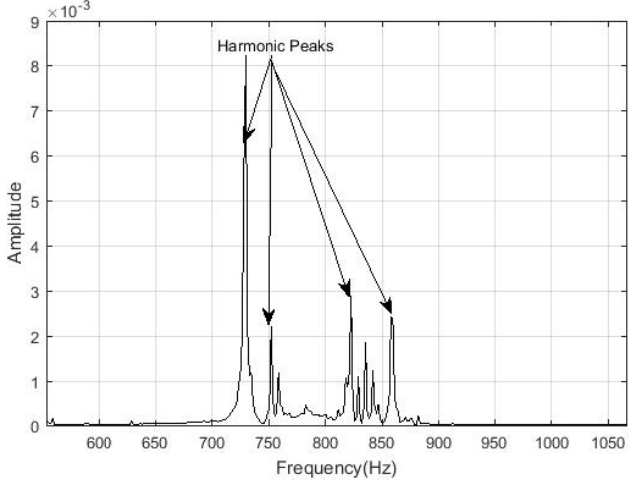
Figure 16. Spectrum of the two broken bars, in relative position 1–2, signal after the noise reduction with the harmonic peaks.